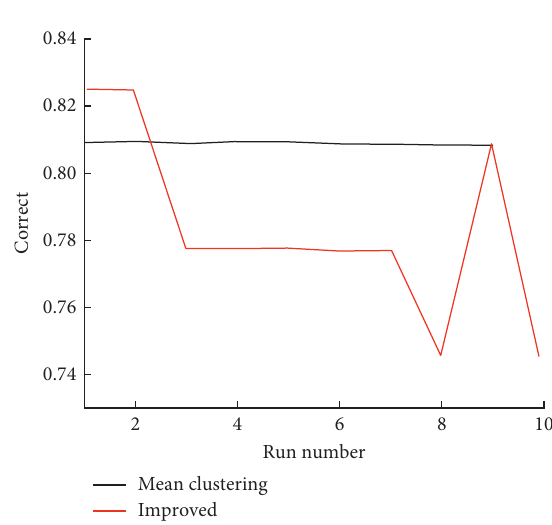
Figure 7: Accuracy and objective function result